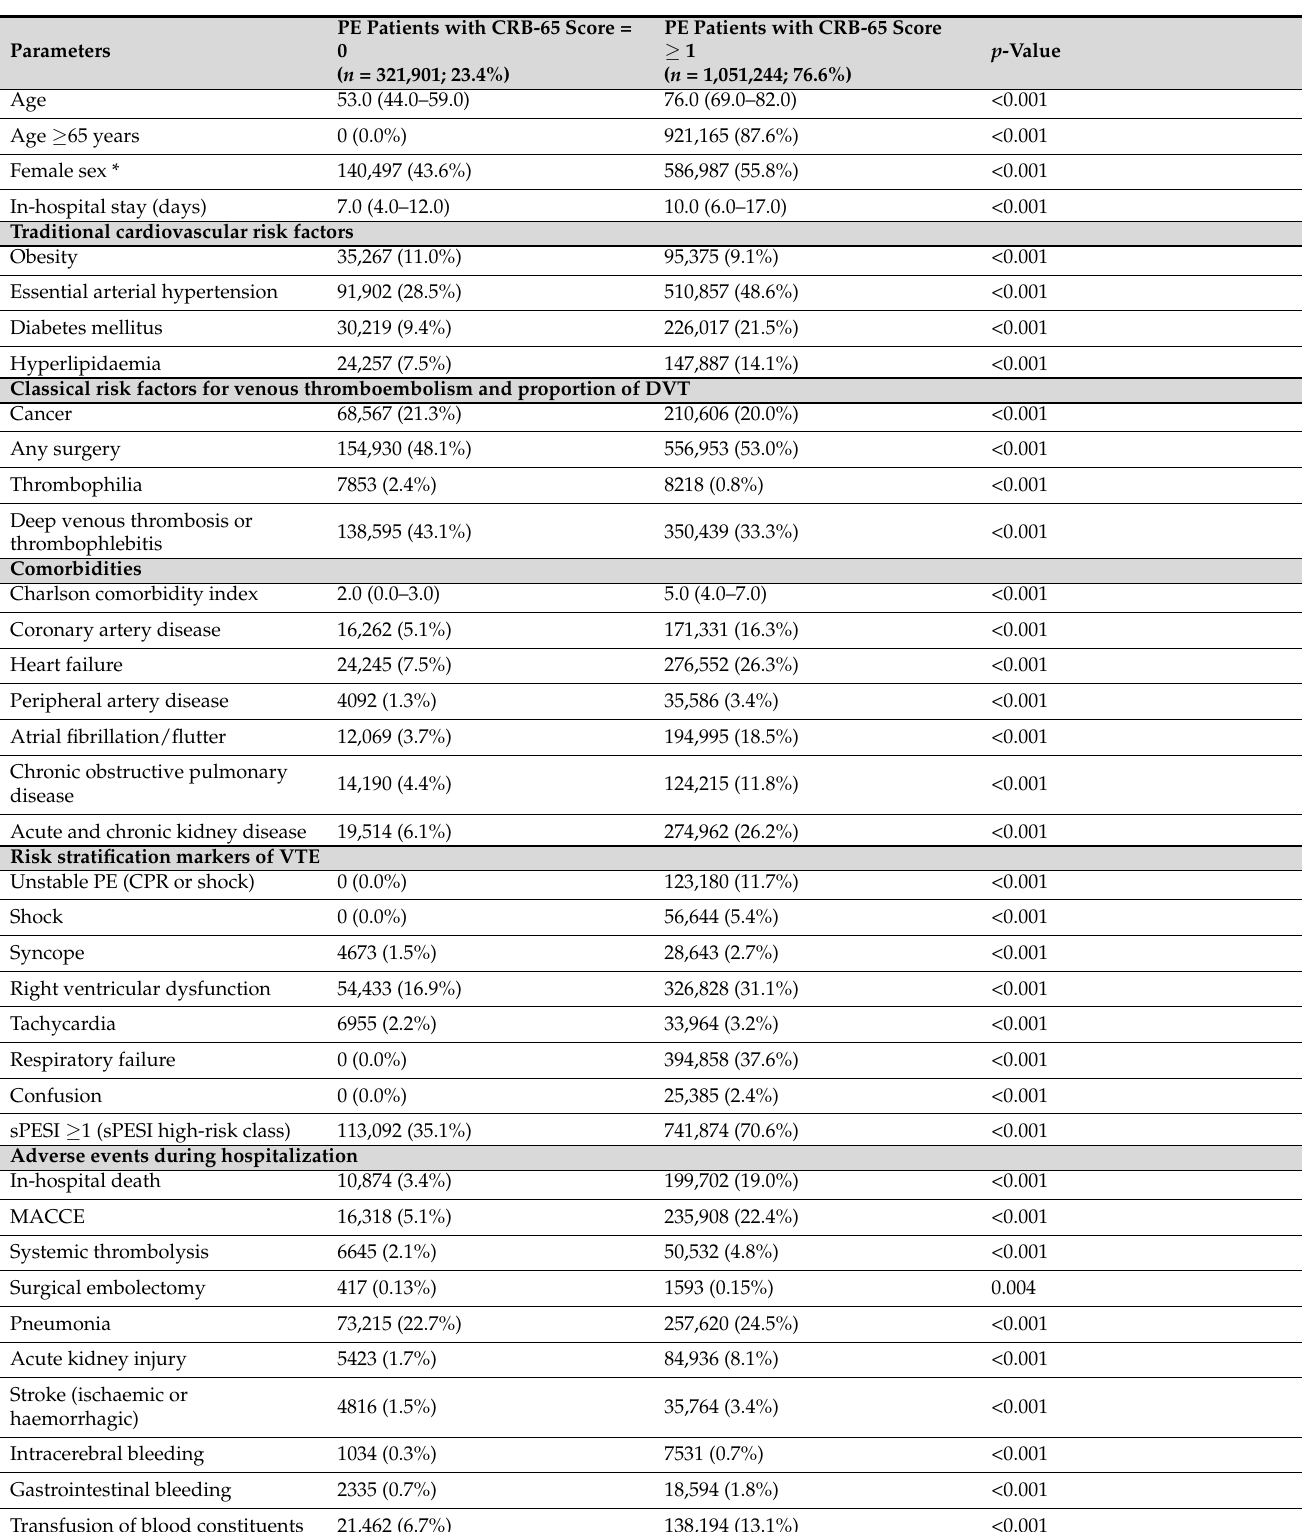
Table 2. Patients’ characteristics, medical history, presentation, and outcomes of the included 1,373,145 patients with pulmonary embolism stratified according to the CRB-65